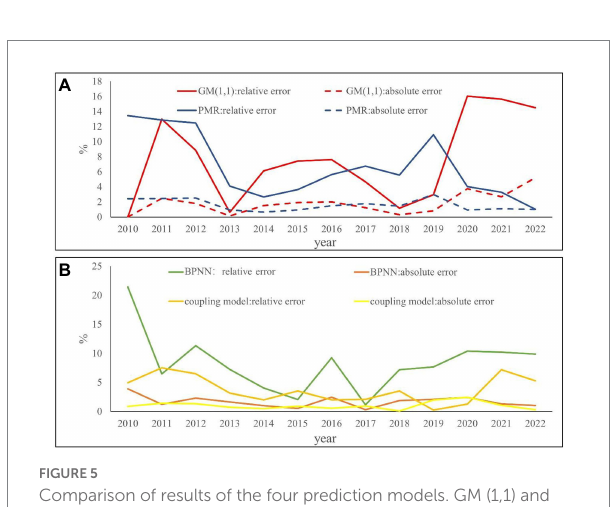
FIGURE 5 Comparison of results of the four prediction models. GM (1,1) and principle regression model (PMR) (A) , BP neural network (BPNN), and coupling model (B) .